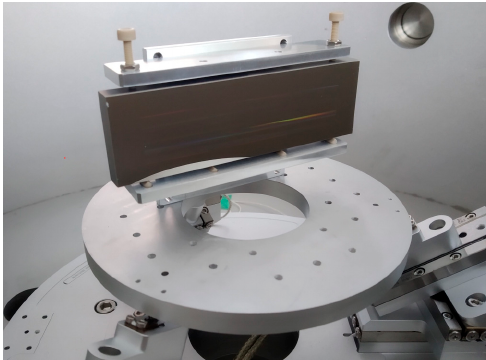
Figure 3. Substrate (100 mm × 30 mm) with two RZPs in its holder, mounted on the SmarPod in the vacuum chamber.